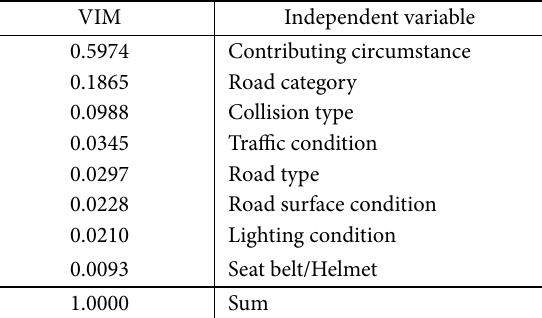
Table 4. Importance of variables in the case of a pruned tree